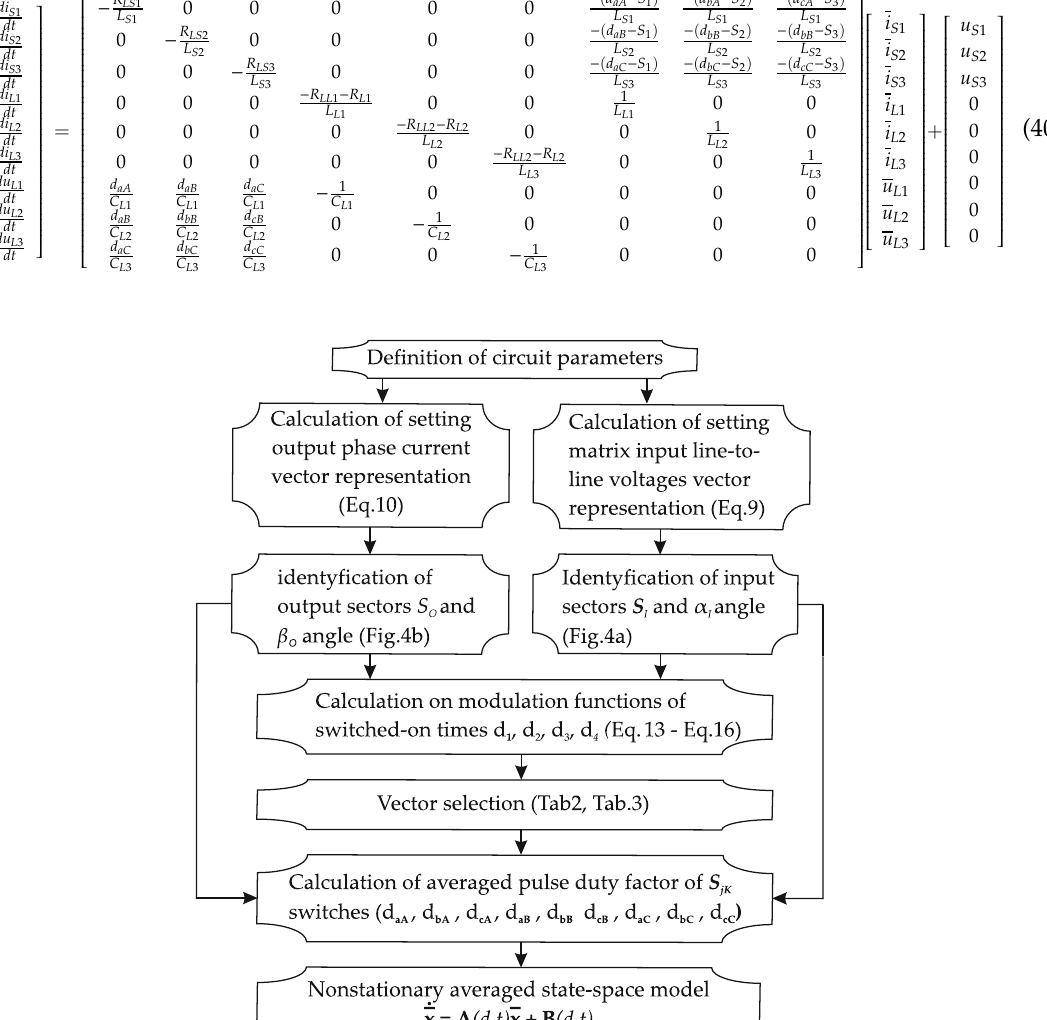
Figure 7. Block diagram of CSMC with SVM system modeling using the average state-space model .